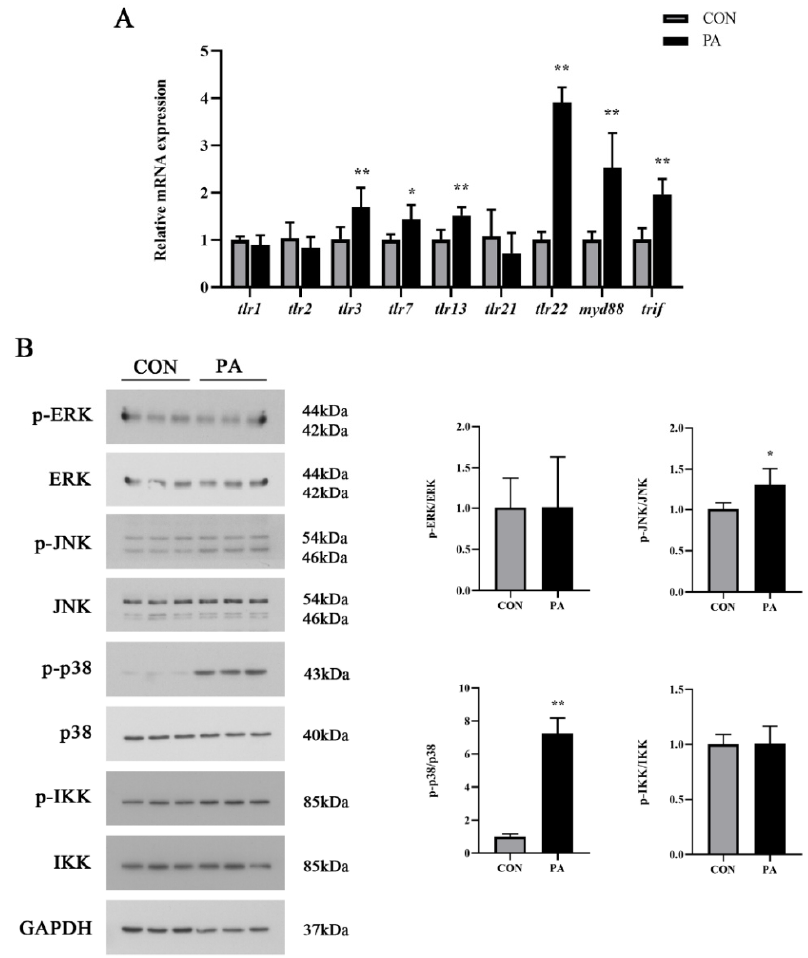
Figure 2. PA activated the TLR-related genes expression and MAPK signaling pathway in macrophages. ( A ) The mRNA expression level of TLR-related genes after PA treatment. ( B ) Western blot analysis of MAPK signaling activation after PA treatment. The ratios of p-ERK to ERK, p-p38 to p38, p-JNK to JNK and p-IKK to IKK were determined. The data are presented as the means ± SEM ( n = 6) and are analyzed using independent t -tests. * p < 0.05 and ** p < 0.01 indicate significant differences compared with the control group.